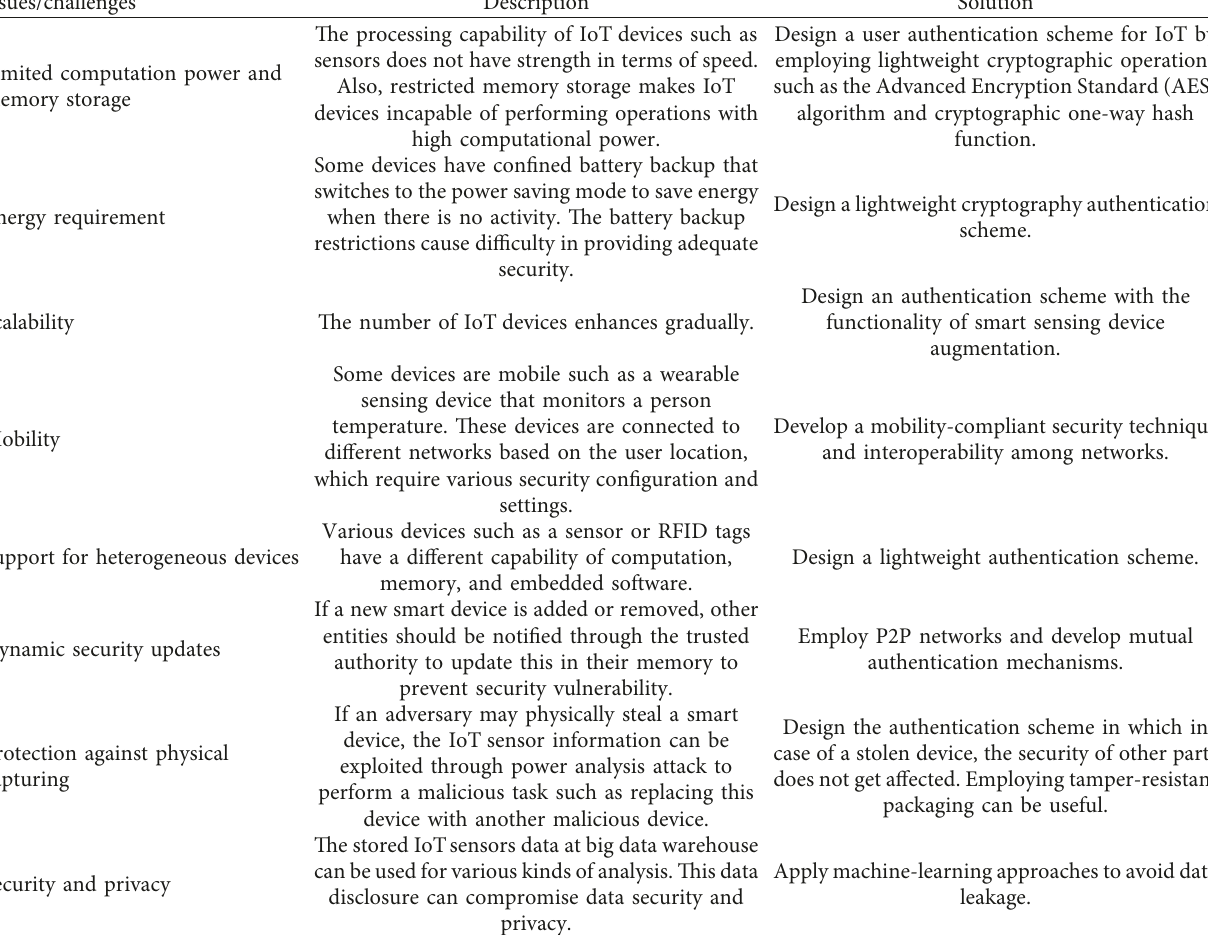
Table 1: Security issues/challenges of authentication schemes for cloud-driven IoT and